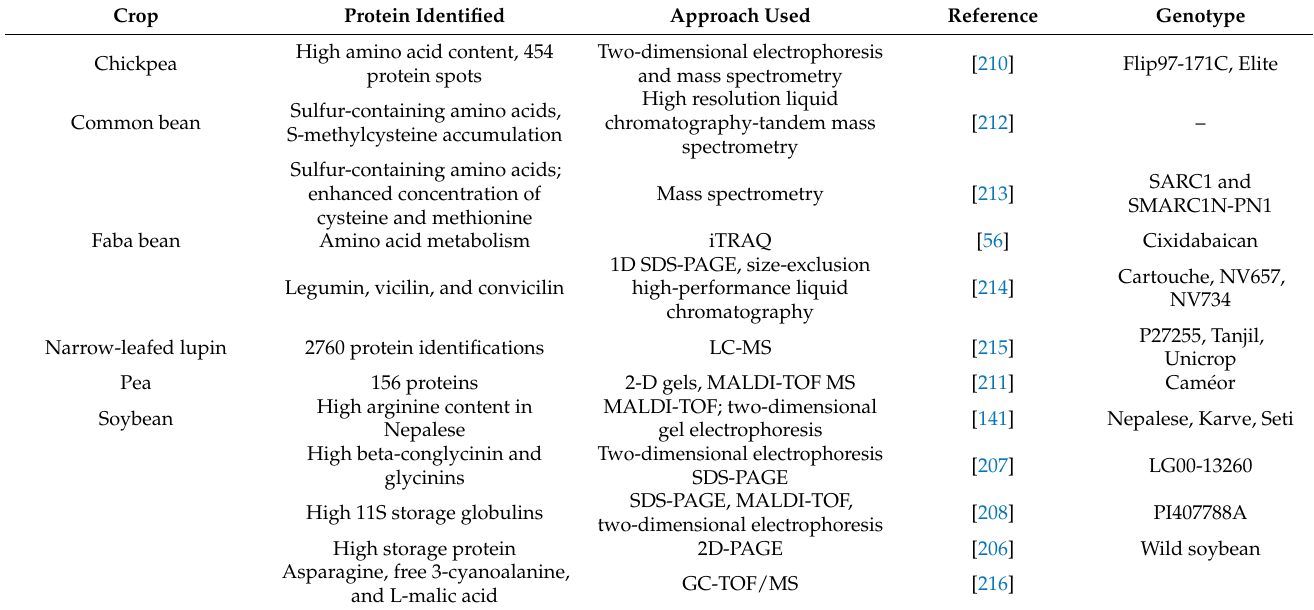
Table 4. Proteomic approach for investigating novel proteins for improving seed protein content in grain